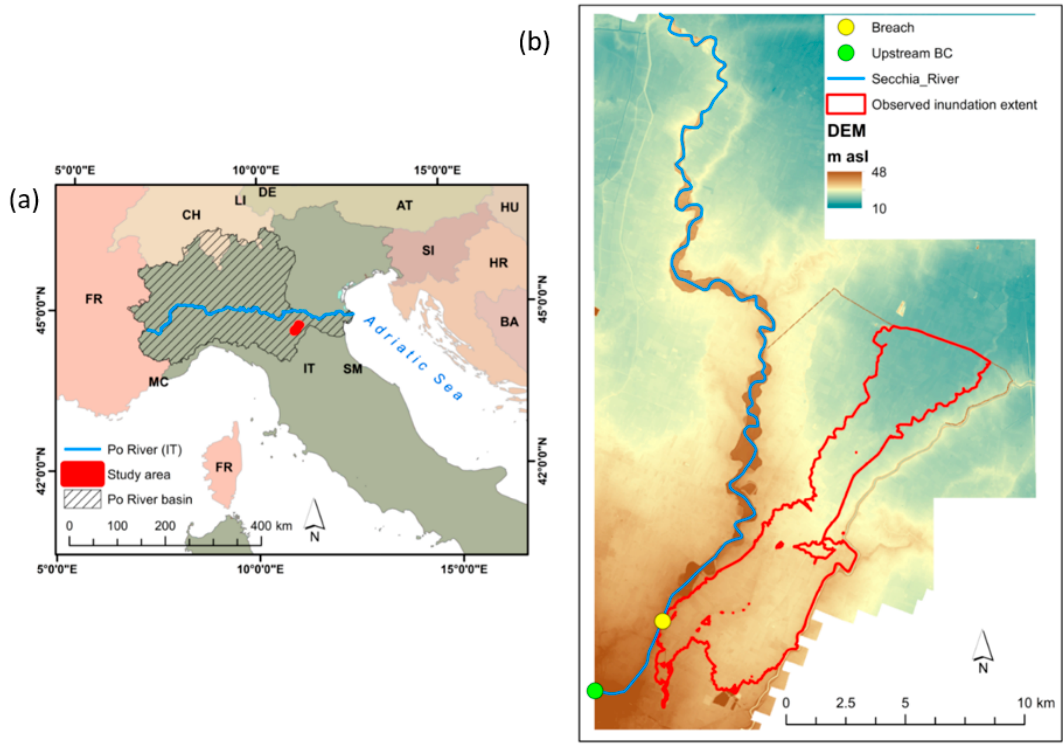
Figure 4. Study area of the Secchia flood: the study area location ( a ); the location of upstream boundary condition (BC), the river channel, breach and floodplain ( b ).